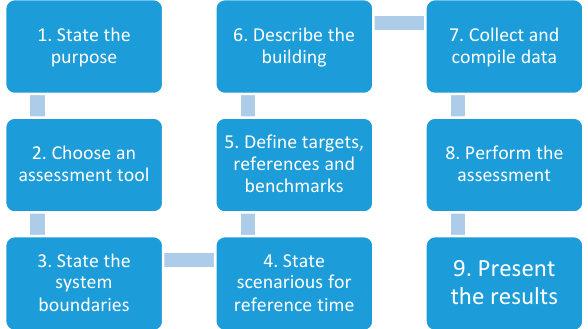
Figure 1. Life-cycle assessment methodology [11].